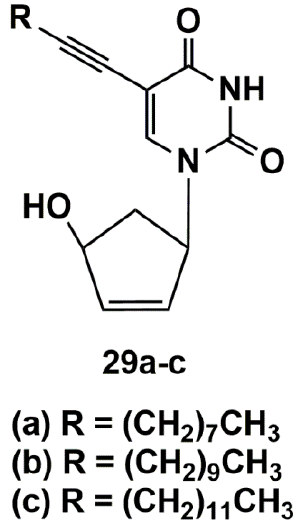
Figure 7. 5 ′ -Norcarbocyclic uracil derivatives. Figure 7. 5 (cid:48) -Norcarbocyclic uracil